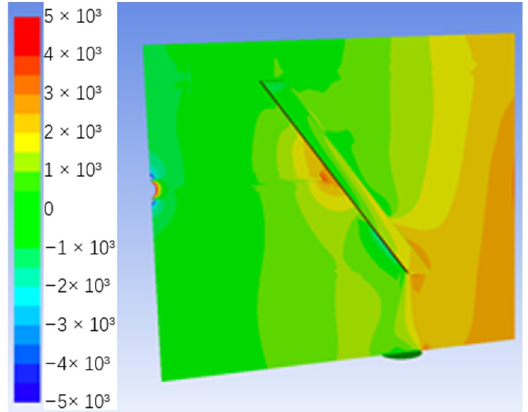
Figure 13. Pressure distribution.